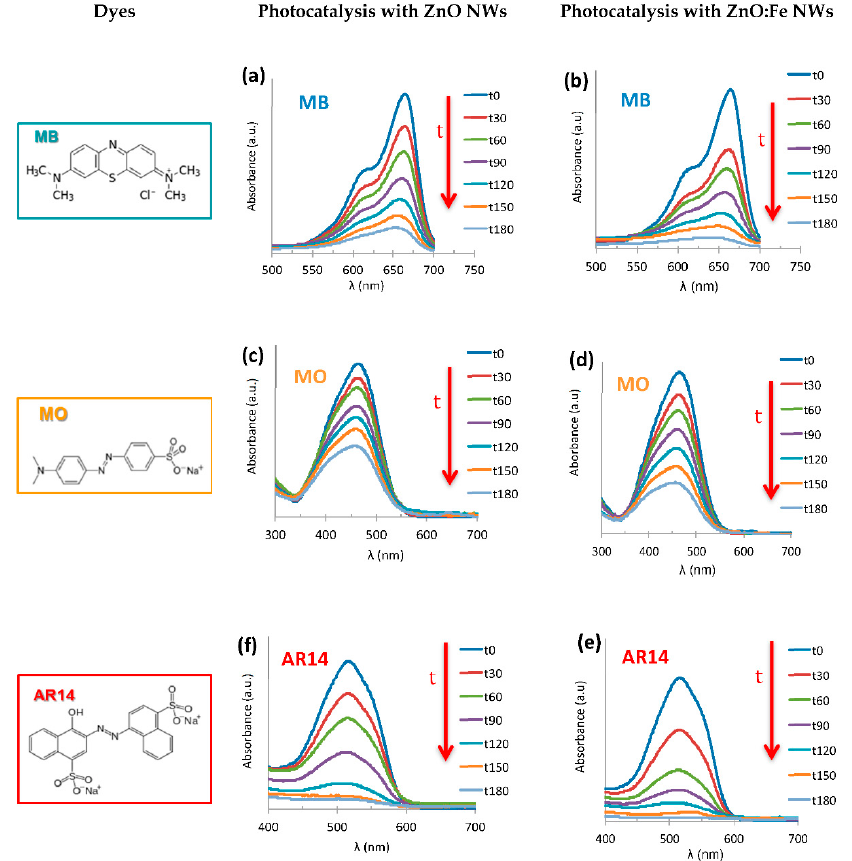
Figure 5. Evolution of ZnO NWs photocatalysis UV-Vis absorption spectra of MB ( a ); MO ( c ) and